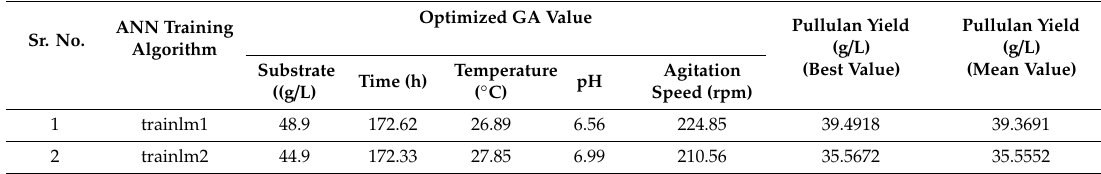
Optimized GA process parameters and outputs corresponding to best fitted ANN training